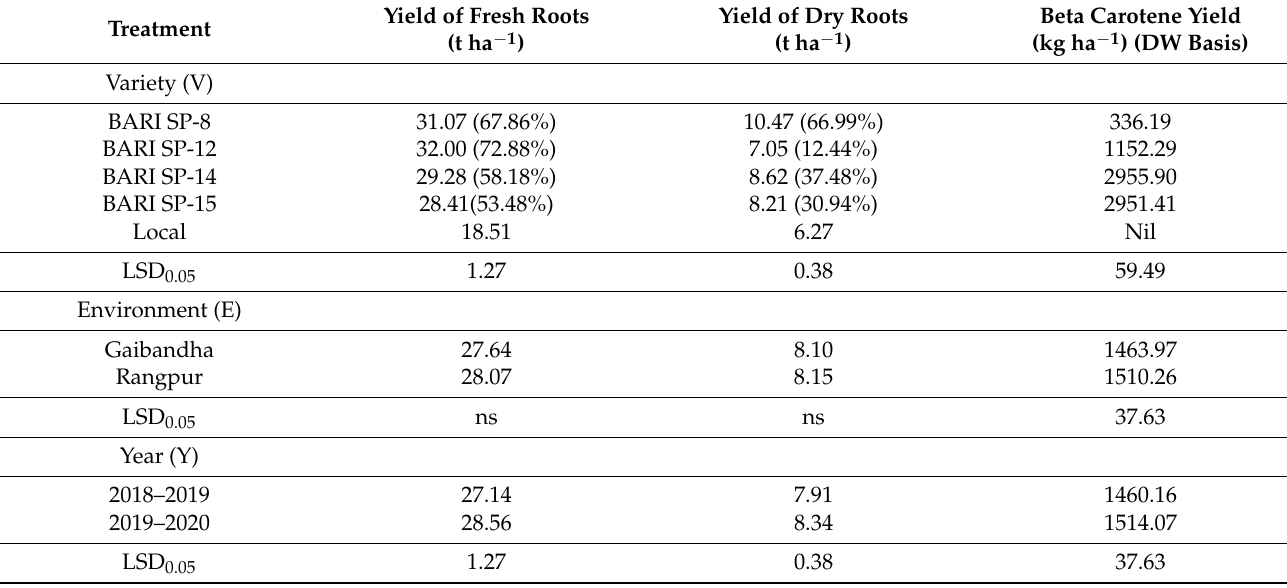
Values within the parenthesis indicate the values increased (%) over check; V, Variety, E, Environment (locations) and Y, Year; ns: non-significant; LSD 0.05 means significant at 5% level of